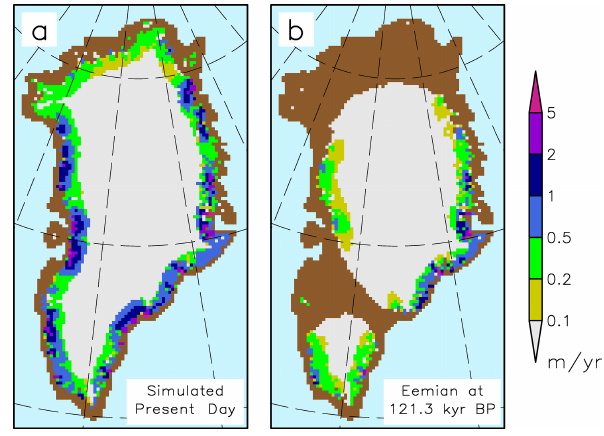
Figure 3. Simulated parameterized divergence of fast ice flow in myr − 1 (Eq. 3) at (a) present day and, (b) at Eemian from the model version with the most reduced Eemian ice